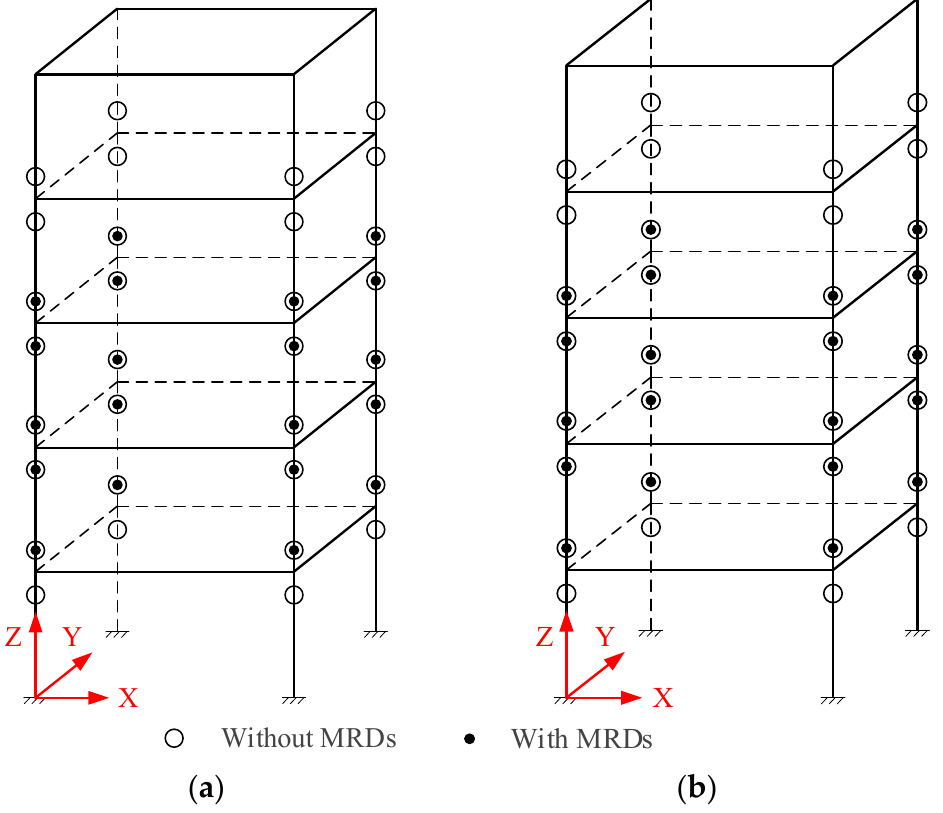
Figure 14. Plastic hinges distribution of RC frame structure with and without MRD under seismic waves. ( a ) X direction; ( b ) Y direction.